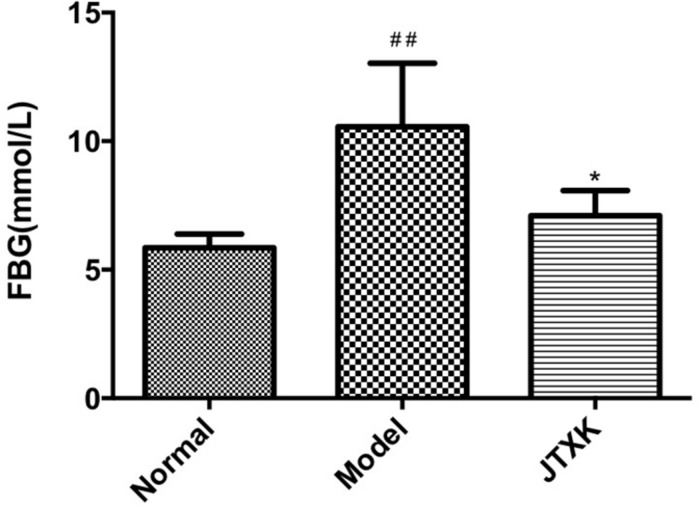
JTXK granule reduced fasting blood glucose level. Results are shown as mean ± SEM. *P < 0.05 compared with model group. ##P < 0.01compared with normal group. Normal group, n = 8; Model group, n = 6; JTXK group, n = 6.